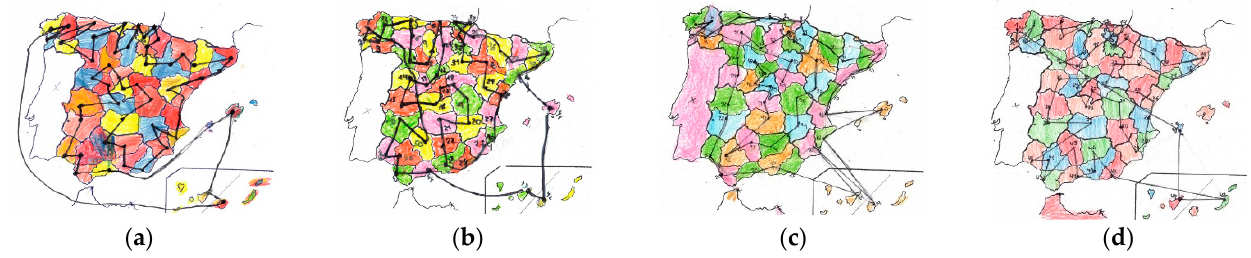
Figure 5. Example of Eulerian cycle. Drawing made by participant: ( a ) A2; ( b ) A3; ( c ) A5; ( d ) A7.